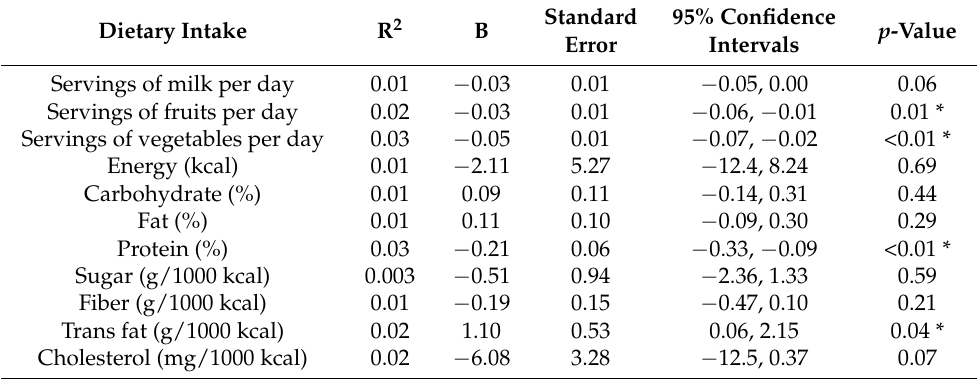
Table 4. Linear regression analyses of picky eating scale scores on dietary intakes of children a . Dietary